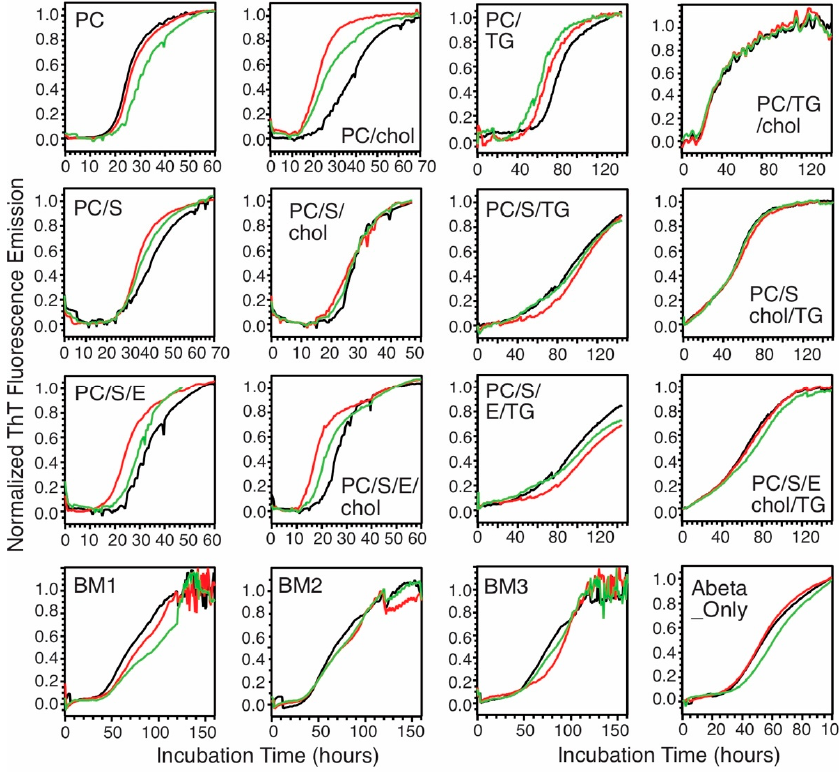
Figure 2. Thioflavin-T fluorescence traces (three repetitions for each membrane composition) for A β 40 fibrillization kinetics in the presence of different membrane models and a control that only contains the peptides.